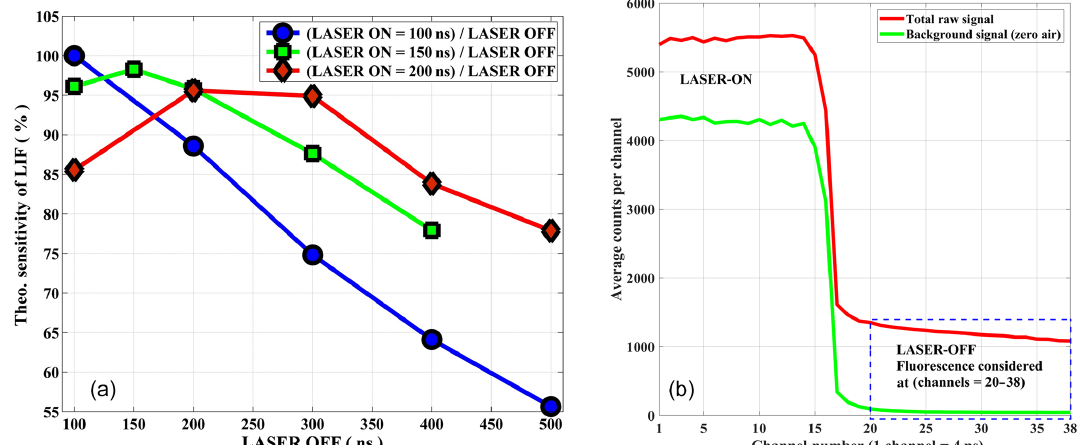
Figure 2. (a) Relative sensitivity of the instrument based on the simulation is demonstrated for three different on–off cycles of diode laser operation. (b) On–off cycle of the laser is shown for a signal of about 12ppb NO 2 ( y axis arb. unit). The sum of channels (20–38) is considered a fluorescence signal for the data analysis. A schematic of the data acquisition system is provided in the